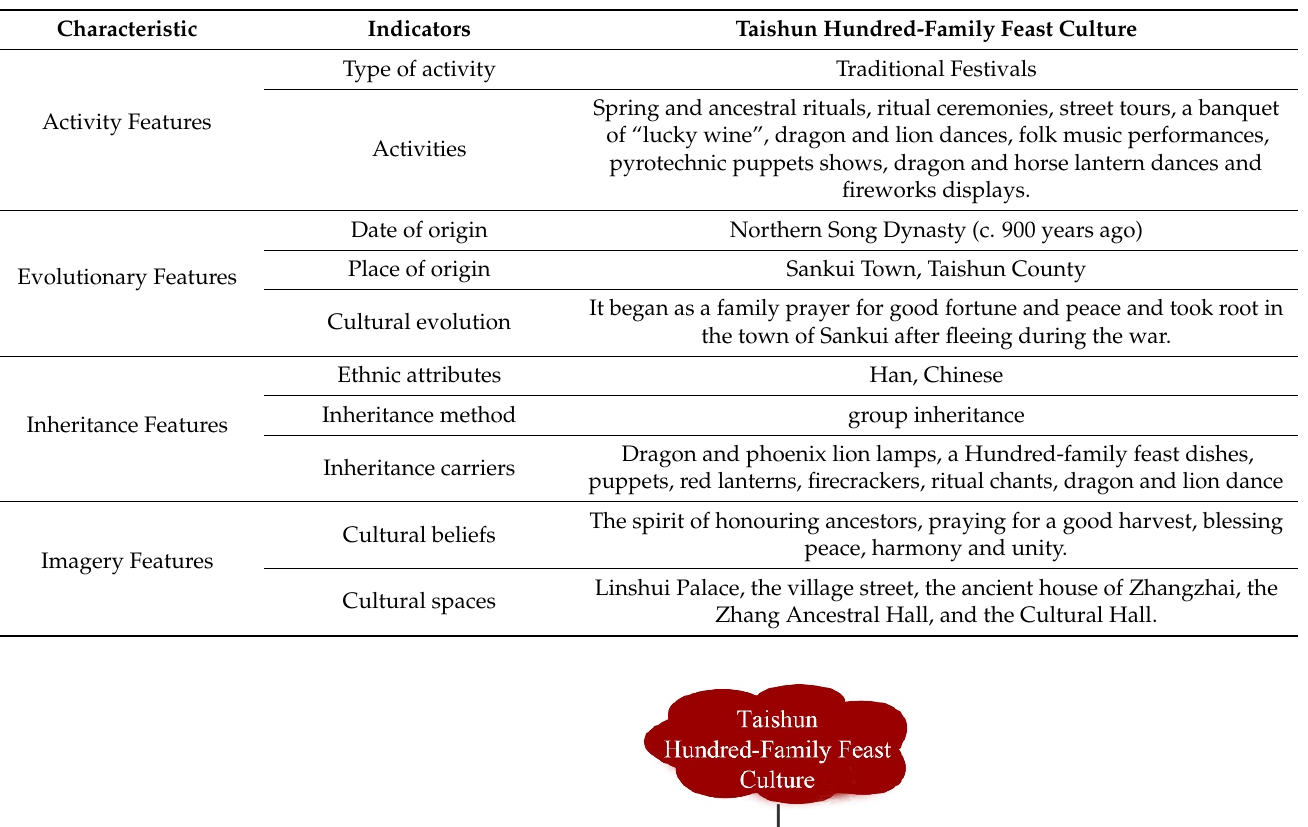
Table 1. Landscape gene mining results of the intangible cultural heritage of Taishun Hundred-family Feast folk activities.